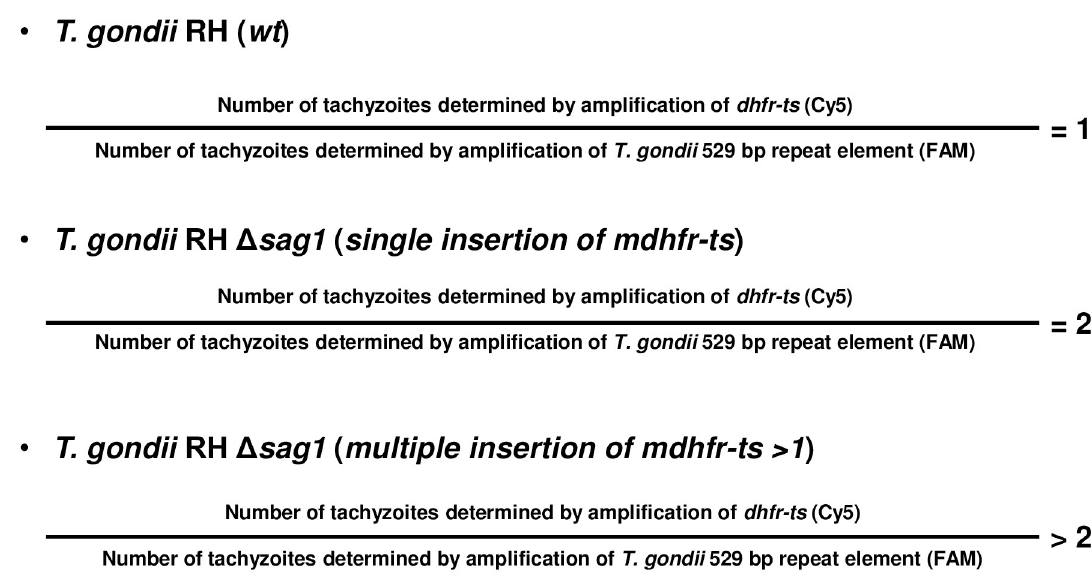
Fig 5. Principle and potential outcome of the duplex TaqMan-qPCR.